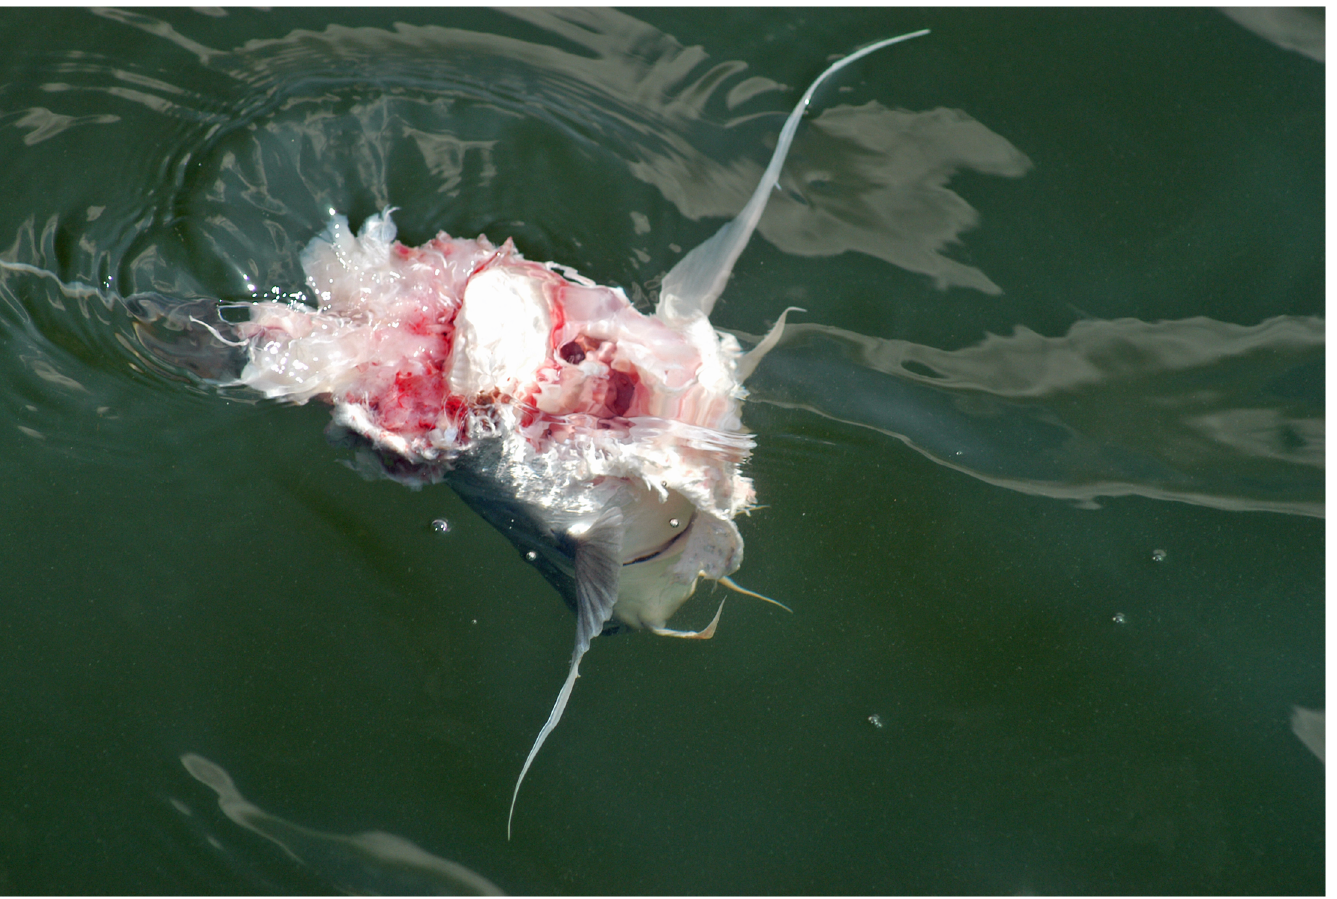
Fig 1. Severedcatfish head ( B . marinus ) found near dolphins demonstrating foraging behavior near Palma Sola Bay, FL (SAR).